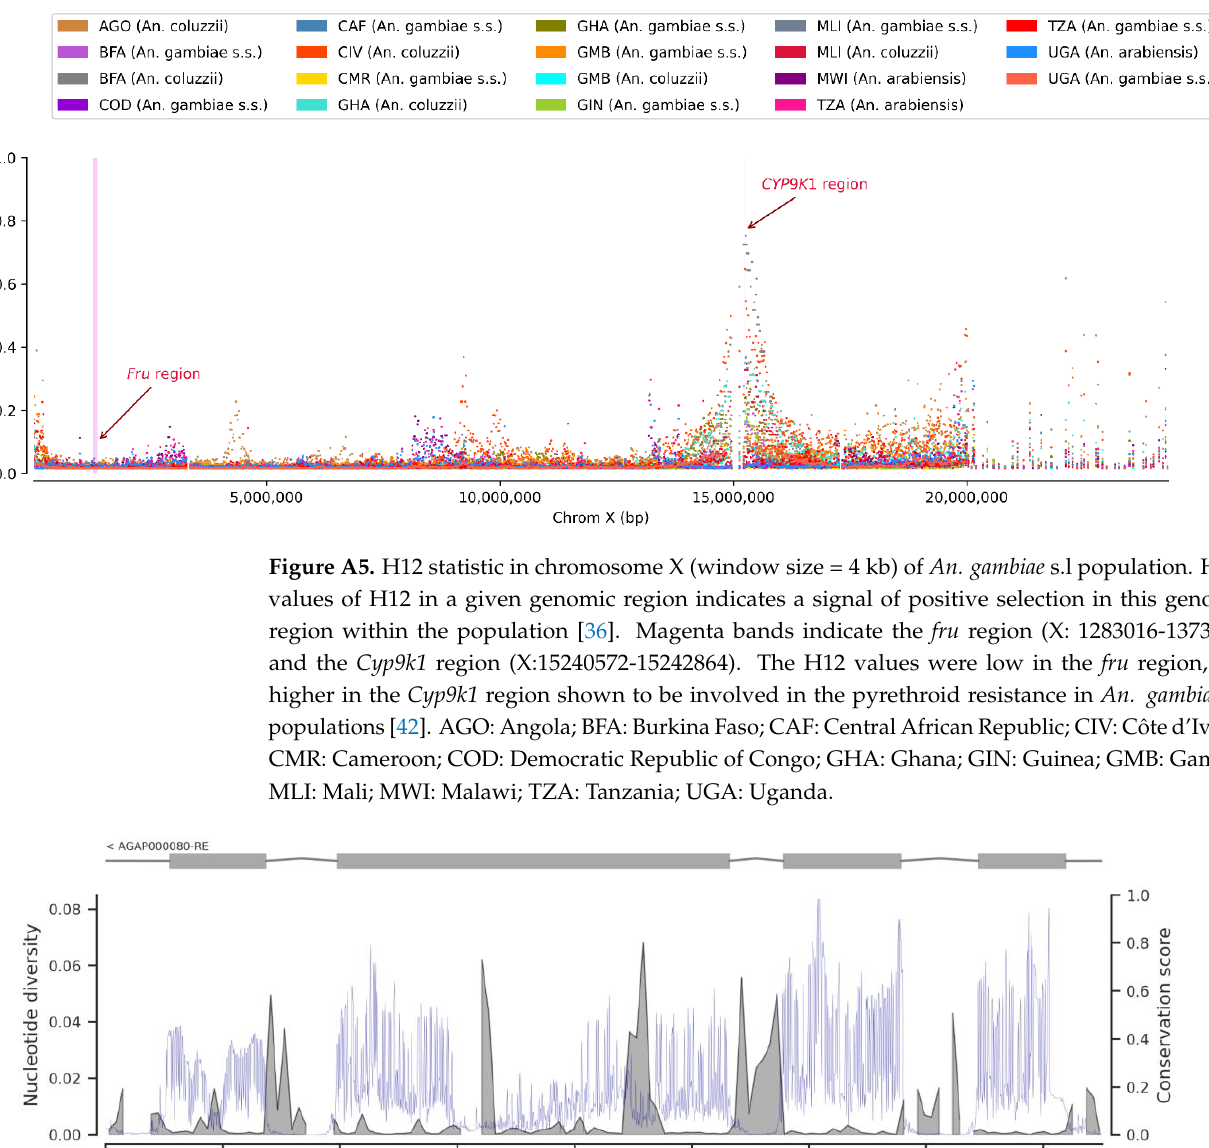
Figure A4. Haplotype diversity in a window of 500 bp across the genomic region of the Fruitless gene; red points indicate the mean of the haplotype diversity. AGO : Angola; BFA : Burkina Faso; CAF : Central African Republic; CIV : Côte d’Ivoire; CMR : Cameroon; COD : Democratic Republic of Congo; GAB : Gabon; GHA : Ghana; GIN : Guinea; GMB : Gambia; MLI : Mali; MOZ : Mozam- bique; MWI : Malawi; TZA : Tanzania; UGA : Uganda.